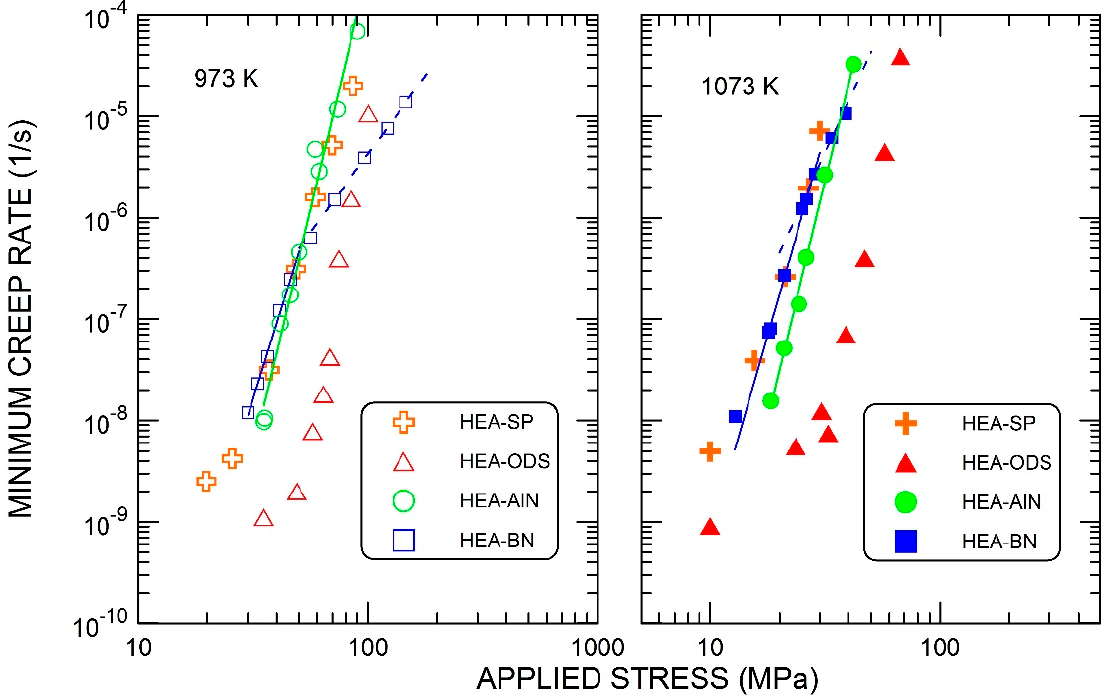
Figure 5. Comparison of the creep behavior of the present alloys, with the single-phase alloy and the alloy strengthened by the dispersion of oxide particles.